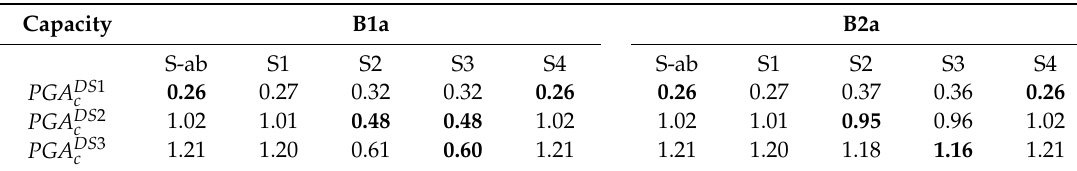
Table 5. Value of PGA capacity for the subassemblies of the B1 and B2 index ‐ bridges. Bold values represent the PGA ‐ based capacity of the corresponding index ‐ bridge.